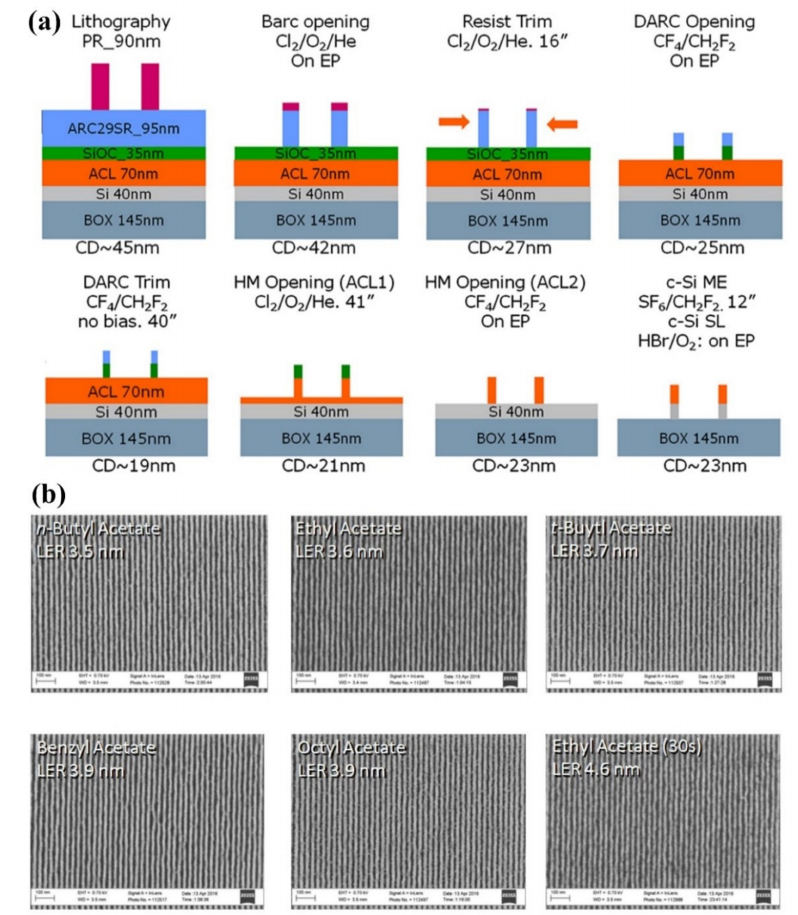
Figure 1. ( a ) Schematic representation of a cross-section of a 10 nm SiNW produced from SOI using a 193 nm immersion lithography process incorporating resist trimming steps and over-etching. Where HM stands for hardmask, ACL for Amorphous Carbon Layer, DRAC for Dielectric Anti-Reflective Coating, and SiOC for Silicon OxyCarbide. ( b ) CDSEM images show LER trend with increasing dose and resist quencher concentration. Figure 1b is reproduced from [68], with permission from SPIE and the author (Alex Robinson),